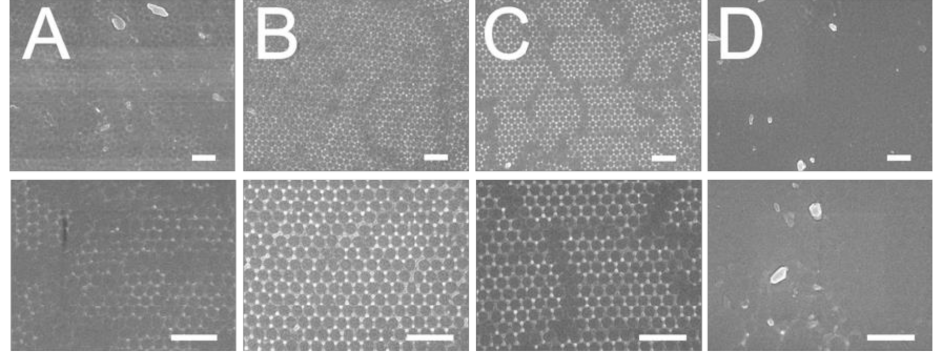
Figure 9. Influence of polydimethylsiloxane (PDMS) to hexane ratio, ( A ) 2:1, ( B ) 1:1, ( C ) 1:2, ( D ) 1:5, on the replication of 300 nm nanosphere array onto the soft mold. (Scale bar: 1 µ m; Magnification: top—12,000 × , bottom—25,000 × ).